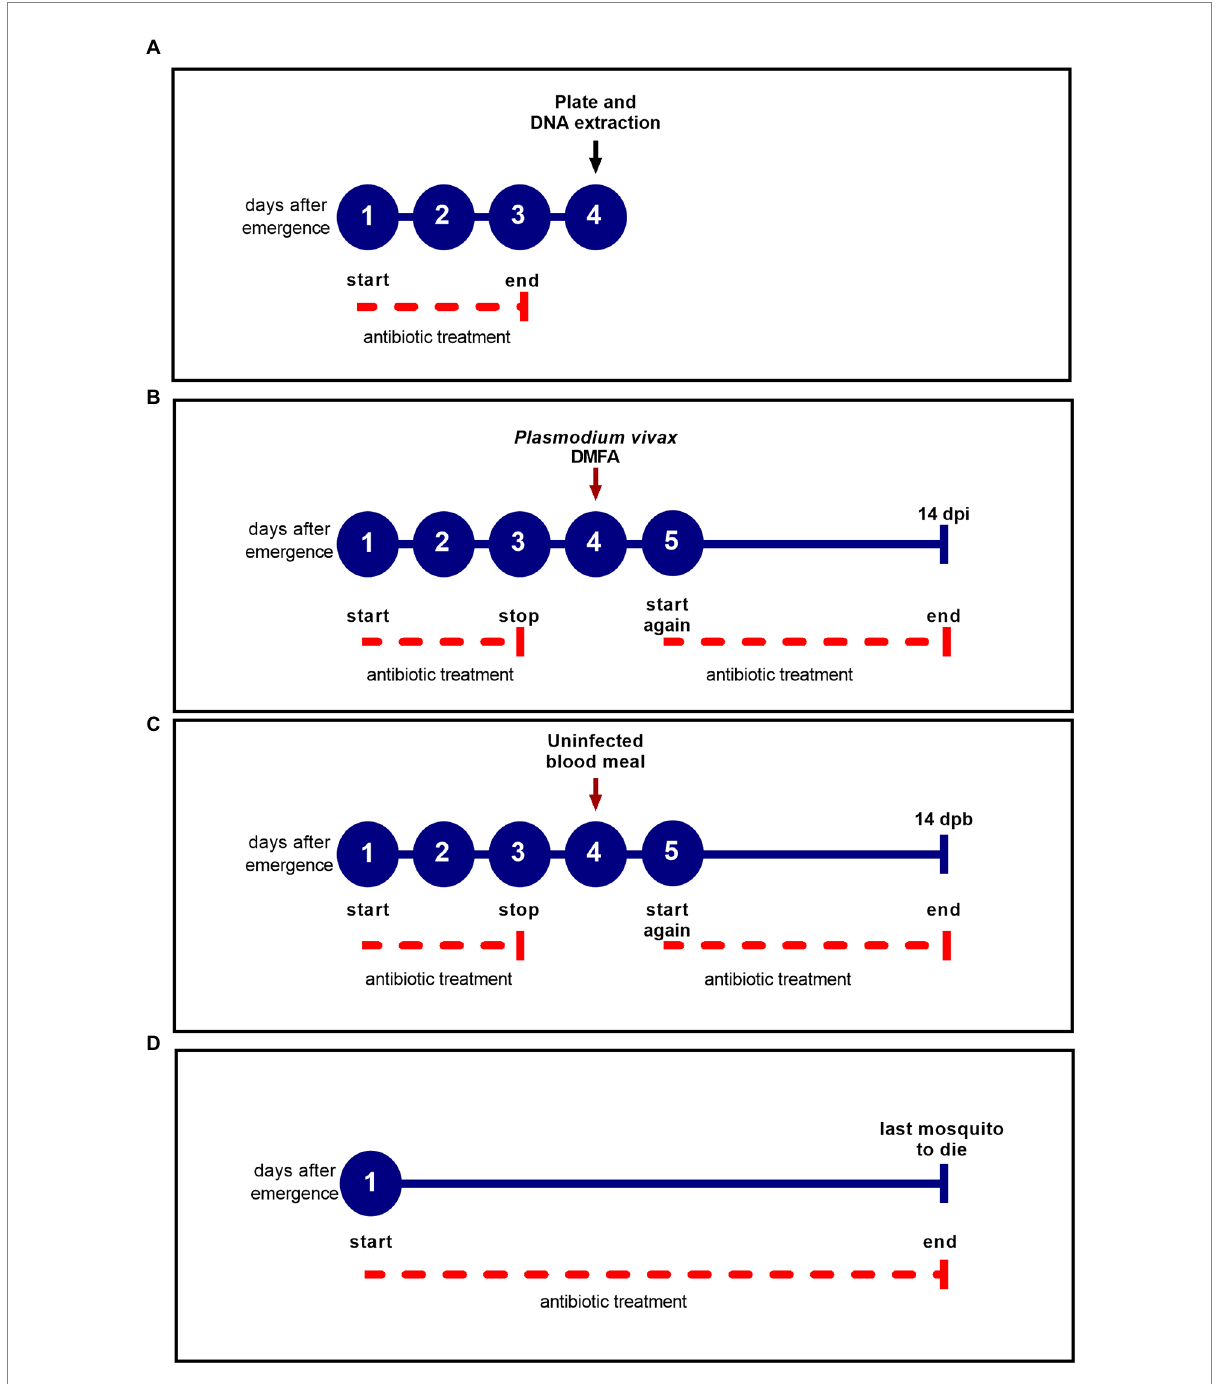
FIGURE 1 Antibiotic treatment scheme for each experiment. The blue circles represent the days after female emergence and the solid blue line represents the experiment duration. The dotted red line indicates the antibiotic treatment period. (A) Experimental design to determine the efficacy of the antibiotic treatment before the DMFA; (B) Experimental design for DMFA; (C) Experimental design for uninfected blood meal; (D) Experimental design for survival